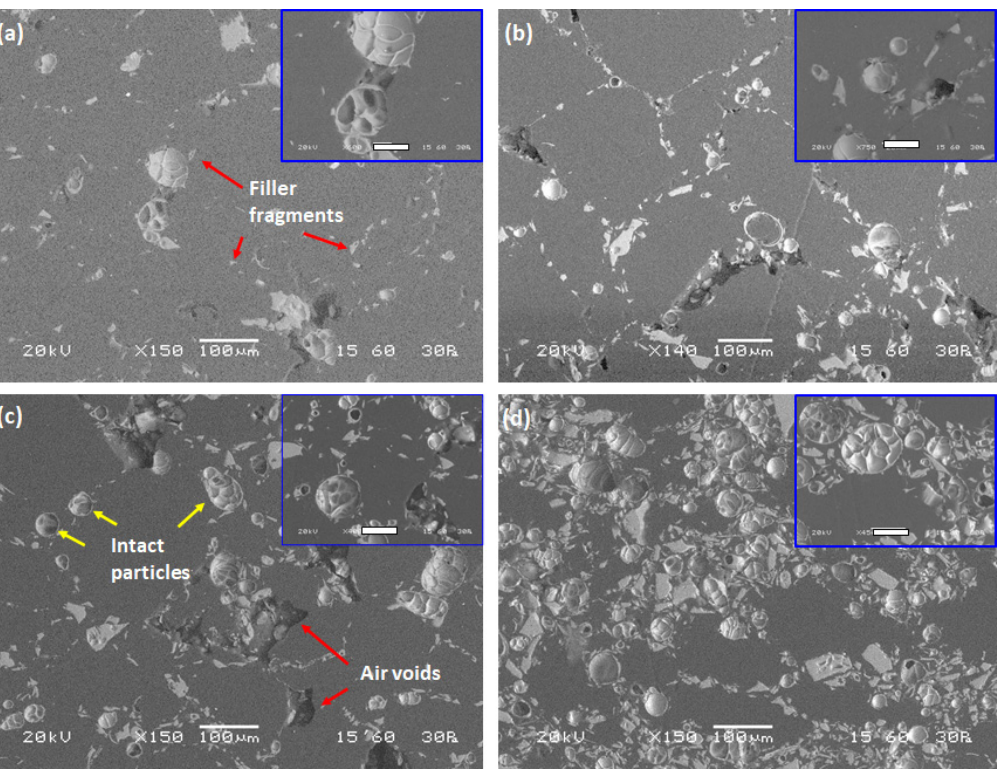
Figure 4. SEM images of cross-section of samples prepared by compression molding with different proportions of F1: ( a ) 5 vol.%, ( b ) 10 vol.%, ( c ) 20 vol.%, and ( d ) 40 vol.%. Regions of interest are depicted in higher magnification at the top right of each image with bar length equal to 40 μ m.